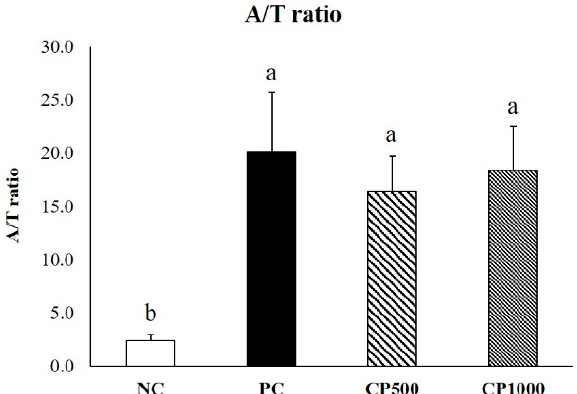
Figure 5. Effect of oral CP administration (500 mg/kg and 1000 mg/kg) on A/T ratio of C57BL/6 mice treated for 6 weeks. The follicles in the anagen phase exhibit a large and thick hair bulb located deep in the epidermis. The telogen phase features a small and flat hair bulb located in a shallow layer of the epidermis. The anagen and telogen phases were confirmed by a histopathologist. Values with different superscript letters are significantly different ( p < 0.05). The results are the mean ± SE ( n = 7/group). NC: negative control (distilled water), PC: positive control (finasteride, 1 mg/kg); CP500: collagen peptide, 500 mg/kg; CP1000: collagen peptide, 1000 mg/kg.